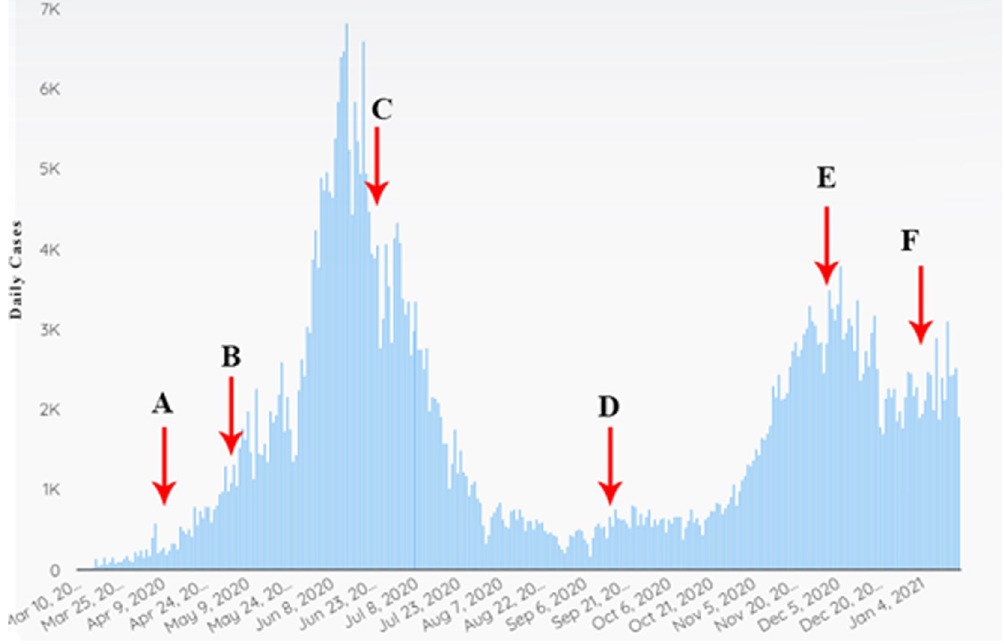
Fig 6. Daily COVID cases in